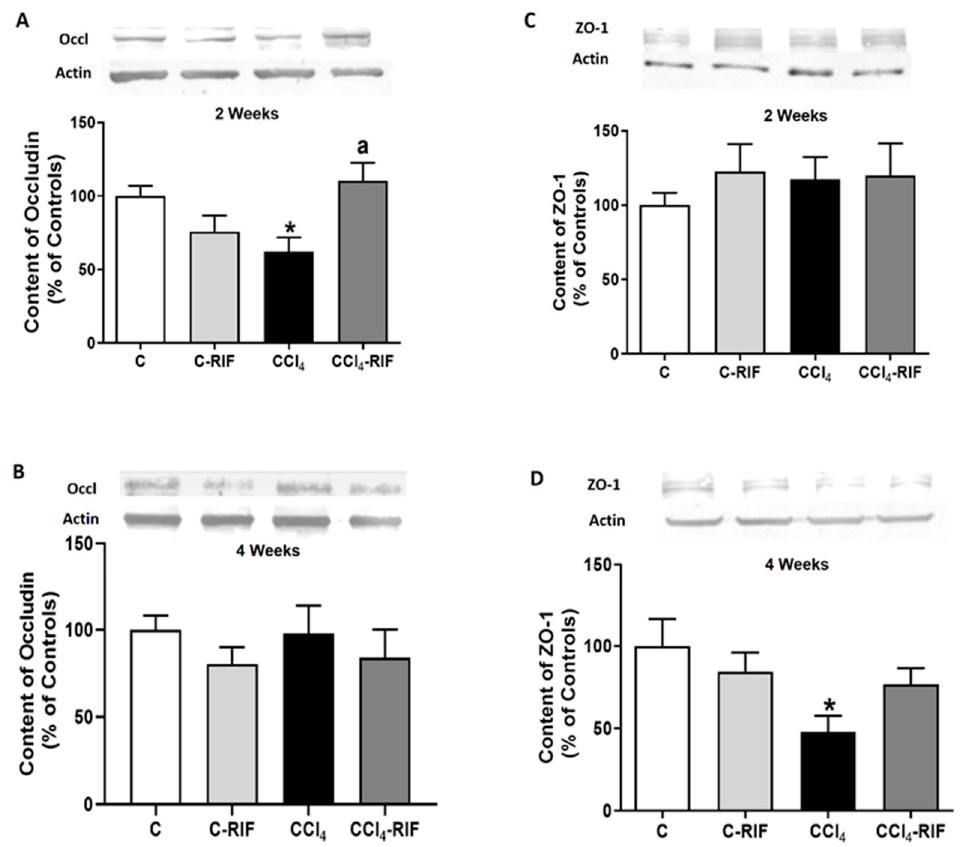
Figure 7. Expression of tight junction proteins in cerebellum of rats with mild liver damage. Expression of ( A , B ) occludin and ( C , D ) ZO-1 at 2 and 4 weeks was analyzed by Western blot. Values are mean ± SEM of 10–12 rats per group. One-way ANOVA with Tukey’s test was performed for occludin at 2 weeks (F(3,27) = 4.99, p < 0.01) and 4 weeks (F(3,47) = 0.611, p > 0.05) and for ZO-1 at 2 weeks (W(3,23) = 0.715, p > 0.05) and 4 weeks (F(3,43) = 3.698, p < 0.05). Values significantly different from control rats are indicated by asterisks and from CCl 4 rats by a. * p < 0.05; a p < 0.05.